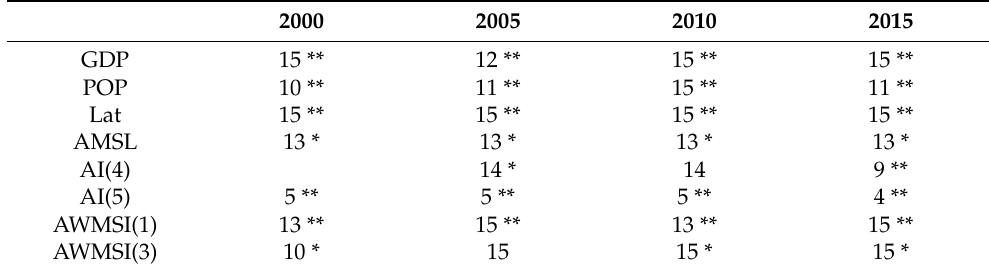
Table A3. The optimal number of categories for discretization of the influence factors of the